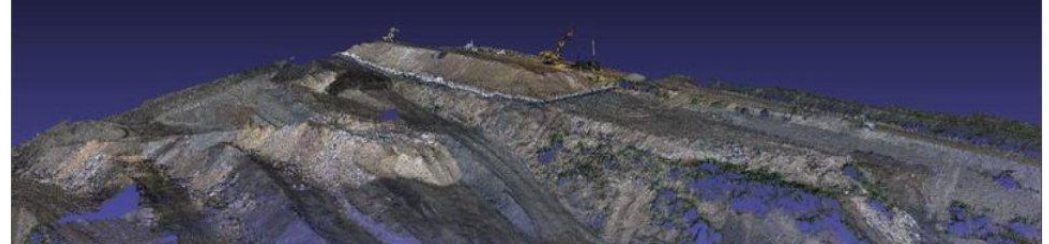
Figure 6. Point cloud of the landfill generated with